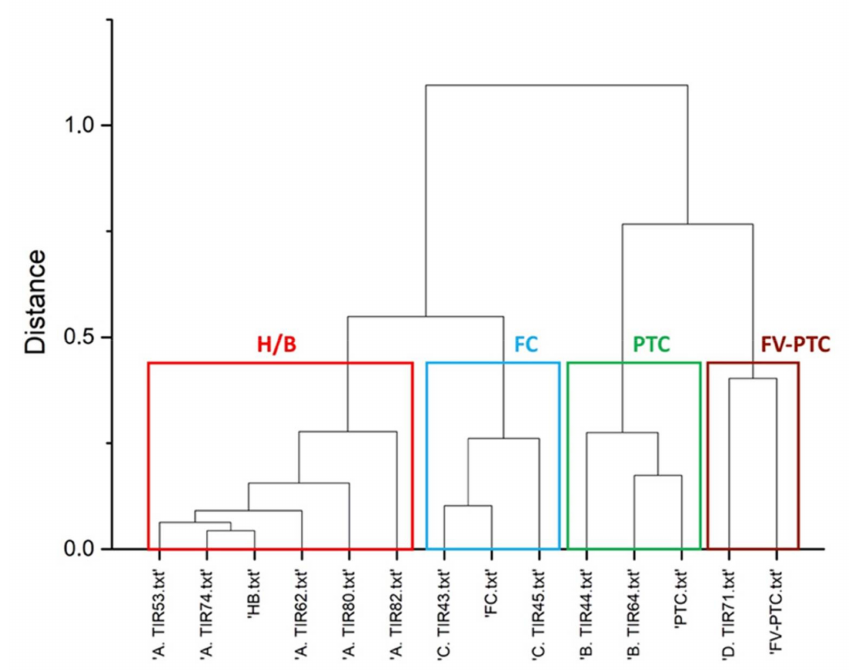
Figure 1. Agglomerative hierarchical clustering analysis (AHCA) dendrogram of the ten adenoma samples investigated. Notice that: 5 of them fall within the healthy cluster (labelled H/B, in red, A), while the others are spread among the three cancer categories, namely follicular carcinoma, labelled FC (blue, C), papillary carcinoma, labelled PTC (green, B)), and follicular variant of papillary carcinoma, labelled FV-PTC (brown, D). HB.txt, FC.txt, PTC.txt, and FV-PTC.txt indicate the reference spectrum for each category.